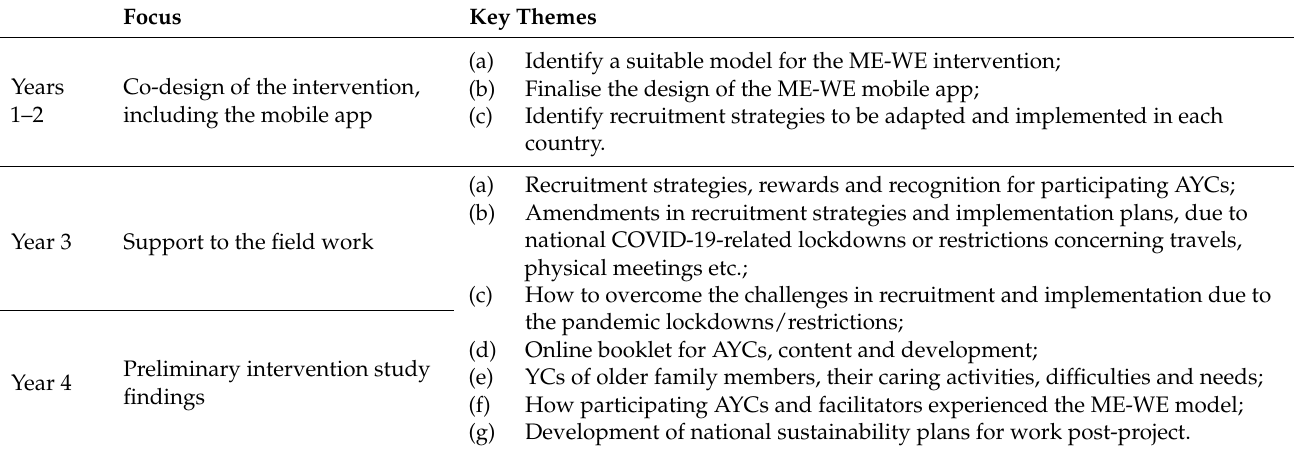
Table 9. Session discussion topics, themes and